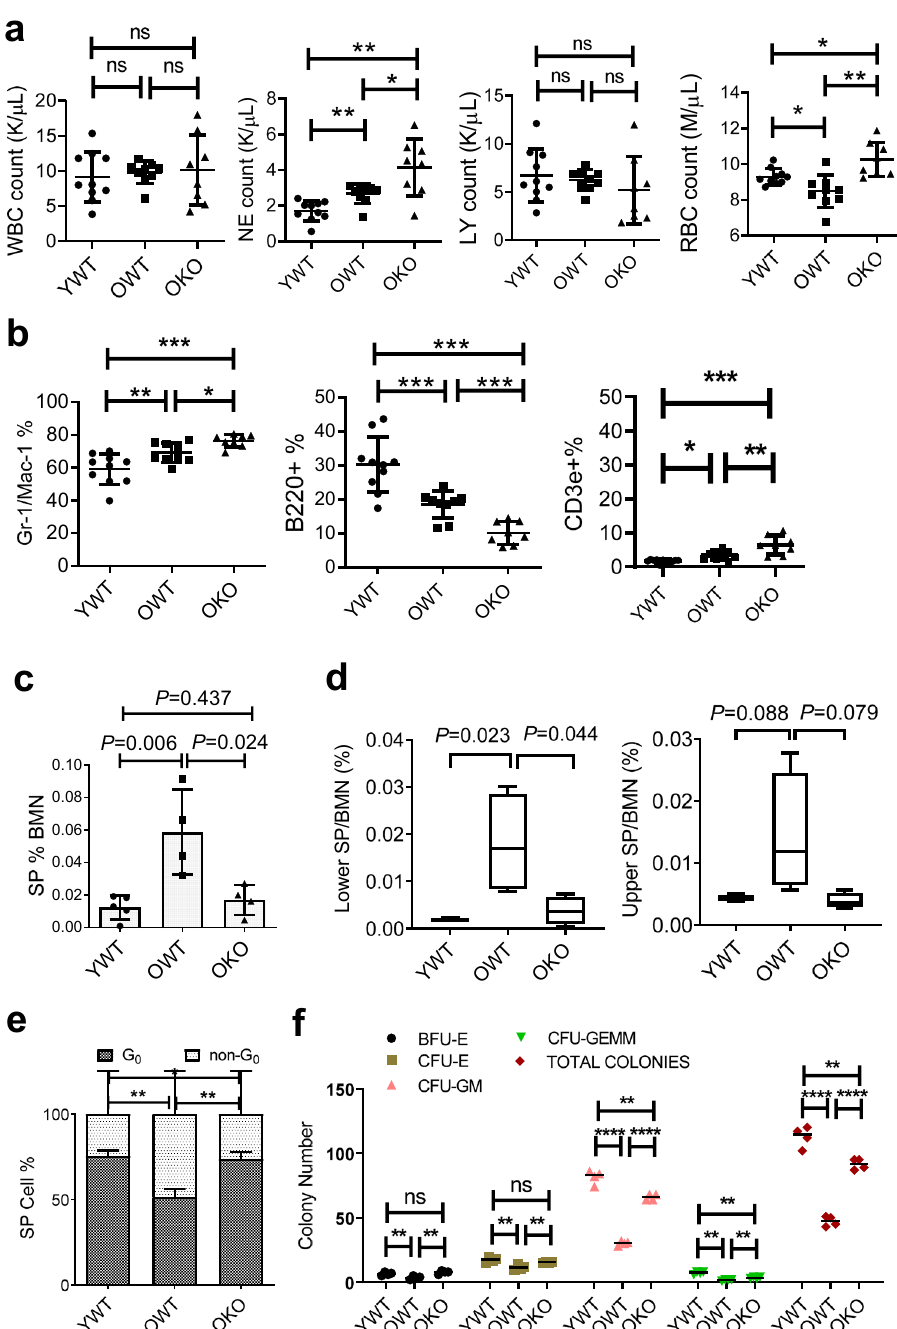
Fig. 1 SIRT1 knockout inhibited HSC expansion and functional decline in aging BALB/c mice. a Comparison of peripheral blood cell counts. WBC white blood cell, NE neutrophil, LY lymphocyte, RBC red blood cell. b Flow cytometry analysis of bone marrow cell lineages for myeloid (Gr-1/Mac-1 + ), B (B220 + ), and T (CD3e + ) cells among total nucleated cells. c Comparison of Lin − SP cells among bone marrow nucleated cells (BMN). d Lower and upper Lin - SP cells. e Cell cycle analysis of SP cells. f In vitro colony formation of bone marrow cells. OWT and OKO mice were in 16 – 20 months, and YWT in 2 – 3 months. CFU colony forming unit, GEMM granulocyte, erythrocyte, monocyte and megakaryocyte, CFU-GM colony-forming unit-granulocyte and monocyte, BFU-E burst-forming unit-erythroid, CFU-E colony-forming unit-erythroid. ** P < 0.01; **** P < 0.0001; ns, not signi fi cant. Error bars represented one standard